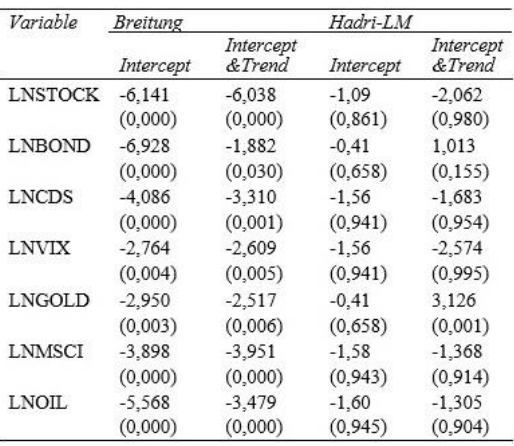
Table 5: Unit Root Test-2